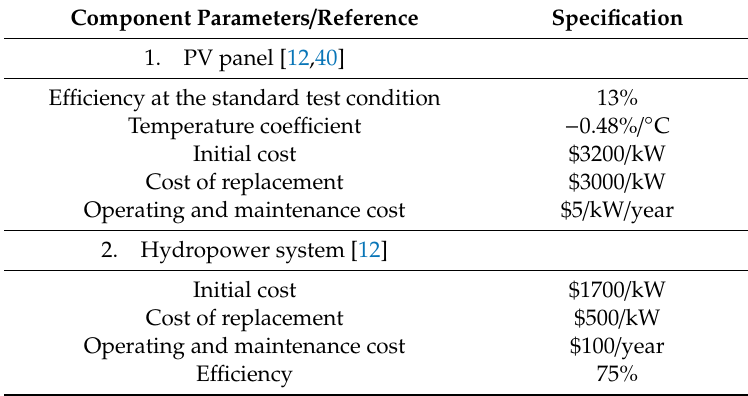
Table 1. System component specifications and costs.